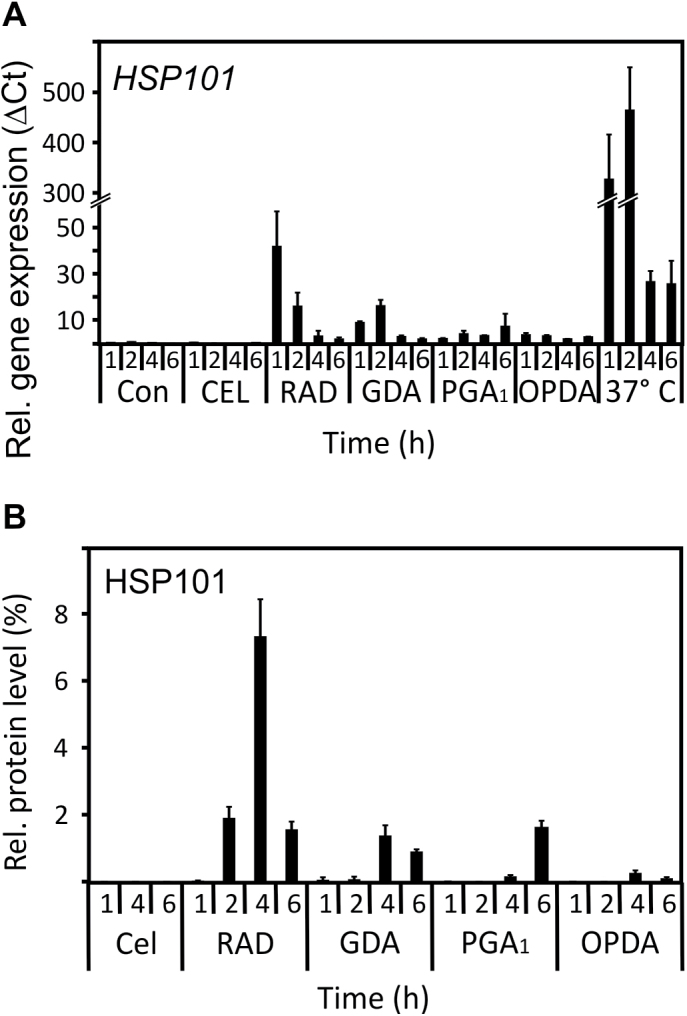
Time-course of HSP101 gene expression and HSP101 protein accumulation after treatment with chemical inducers or moderate heat. (A) Seedlings were treated with the HSP90-inhibitors celastrol (CEL, 20 µM), radicicol (RAD, 50 µM), geldanamycin (GDA, 50 µM), and the RES cyclopentenones (PGA1 and OPDA, 75 µM) for the times indicated. HSP101 mRNA levels were determined by qPCR and normalized to AtSAND; data represent means ±SD, n=3. (B) Relative HSP101 protein levels were evaluated by dot blot analysis and shown as a percentage of seedlings subjected to 37 °C heat treatment for 4 h. Data represent means of three technical replicates of a representative experiment ±SD.